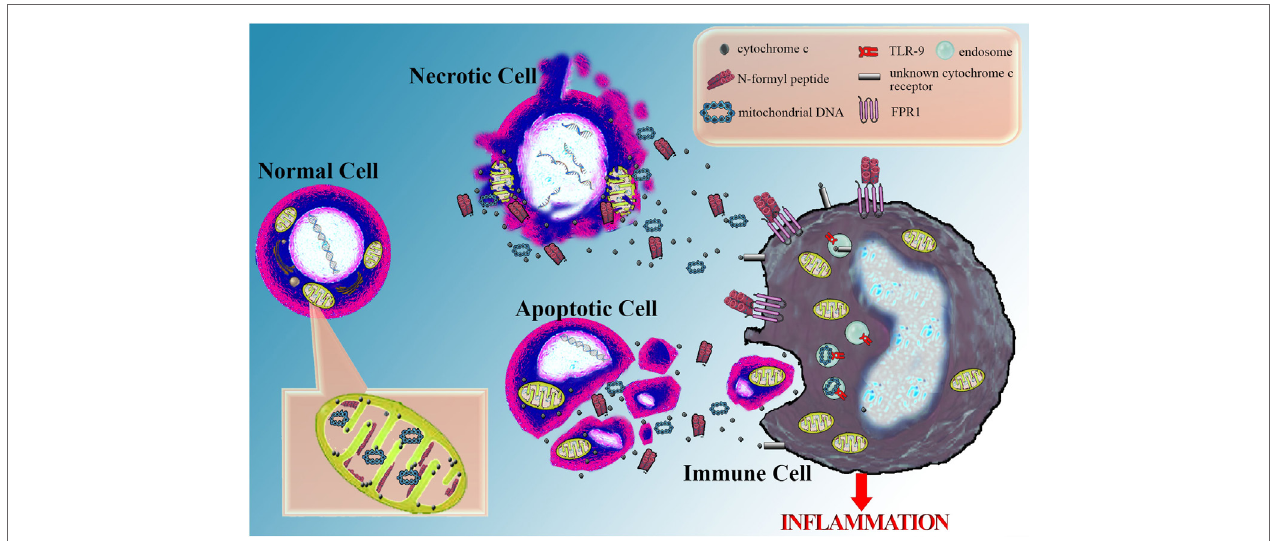
FiGURe 1 | Cytochrome c as a marker of cellular damage and its potential role as a danger-associated molecular pattern . Serious cellular damage results in cell apoptosis or necrosis. In both cases, cytochrome c is released into the extracellular space and can be easily measured in the serum serving as a marker of severe cellular damage and death. Possibly, along with cytochrome c , other mitochondrial molecules are also released into the extracellular space. Among them are annotated some well-defined danger-associated molecular patterns (DAMPs), such as mitochondrial DNA, recognized by the toll-like receptor 9 (TLR9) into the endosomes of immune cells and N -formyl peptides, sensitized by the formyl peptide receptor 1 (FPR1) on the cell membrane of immune cells. Besides the above DAMPs, which resemble bacterial structures, there is evidence that cytochrome c , a universal self-molecule, when is inappropriately located into the extracellular space may behave as a DAMP and elicit an inflammatory response. However, further studies are required for supporting this role for cytochrome c and the responsible pattern recognition receptor(s) remain to be